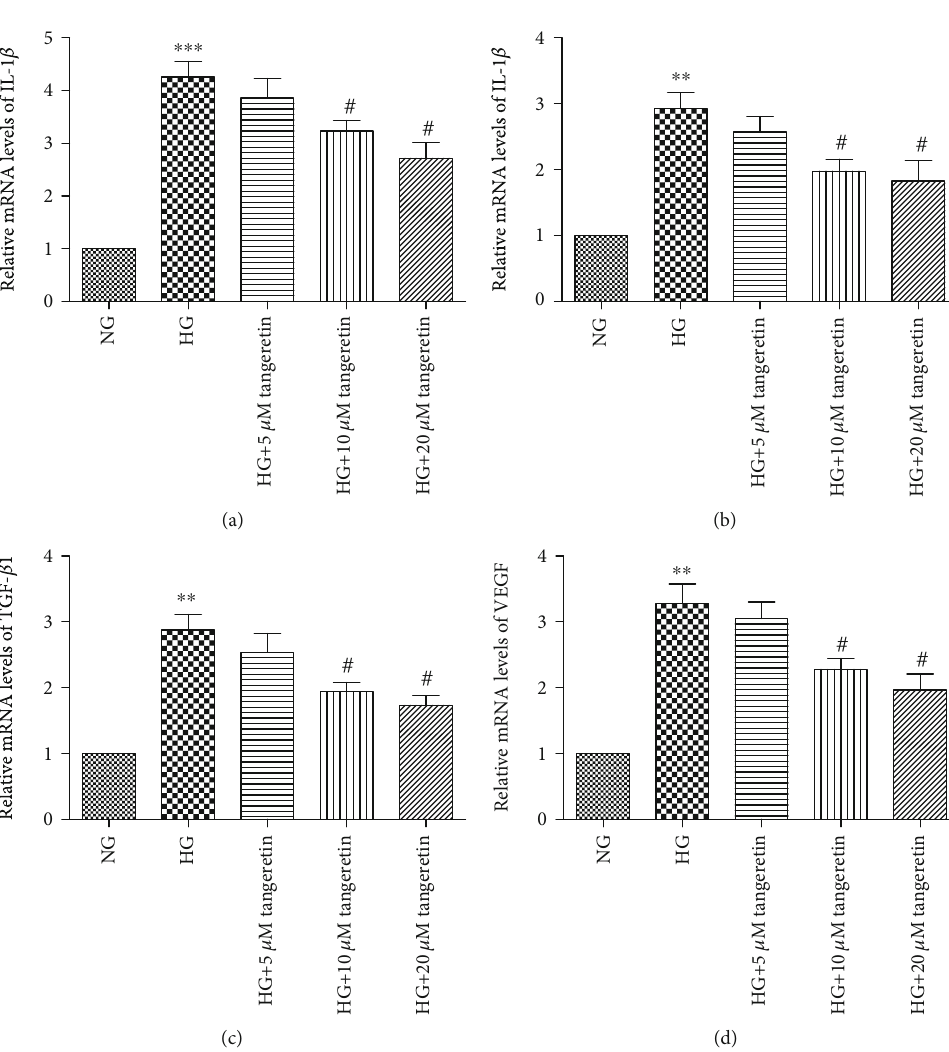
Figure 4: Tangeretin inhibited the mRNA expression of IL-1 β , IL-6, TGF- β 1, and VEGF in RPE cells. RPE cells were pretreated with various concentrations of tangeretin (5 μ M, 10 μ M, and 20 μ M) for 1 h and then stimulated by the addition of HG (30 mM) for 24h. A real-time PCR analysis was performed to assess the expression of IL-1 β , IL-6, TGF- β 1, and VEGF. Tangeretin signi fi cantly decreased the HG-induced mRNA (a – d) level of IL-1 β , IL-6, TGF- β 1, and VEGF in RPE cells in a dose-dependent manner. Values are expressed as the mean ± SD of three independent experiments. ∗∗ p < 0 : 01 versus NG; ∗∗∗ p < 0 : 001 versus NG; # p < 0 : 05 versus